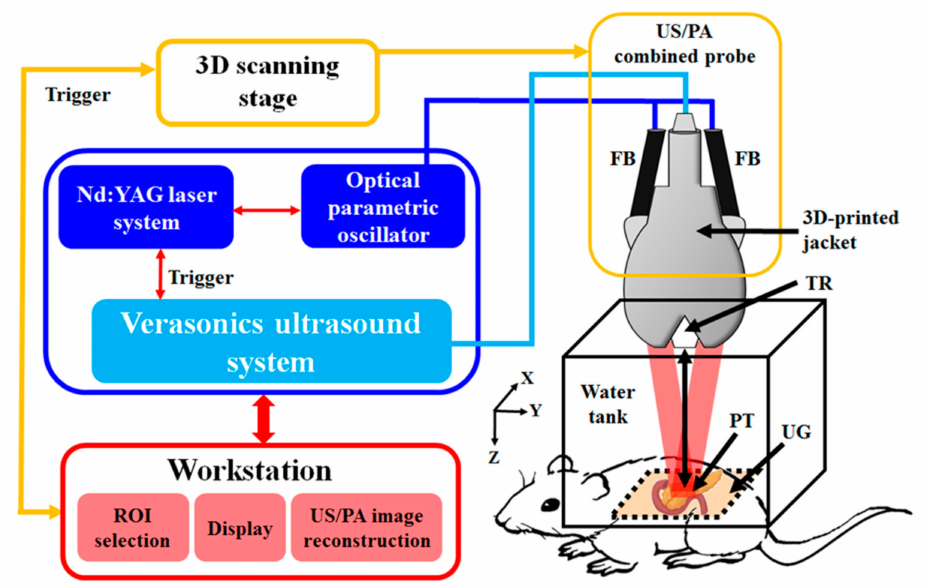
Figure 1. Schematic diagram of the developed dual-modality US/PA imaging system. Using the photoacoustic effect, US waves were generated by delivering light generated by a laser to the imaging target with a pulse repetition rate of 20 Hz using fiber bundles. The US waves were then detected by a 17.5-MHz transducer and processed through a Verasonics ultrasound system. The developed PA probe includes a removable fiber bundle-based illumination system (FB), a single US transducer (TR), and a customized jacket. Two rectangular parts constituted the output end of the fiber bundle, and the input end was circular in shape. ROI, region of interest; PA, photoacoustic; US,